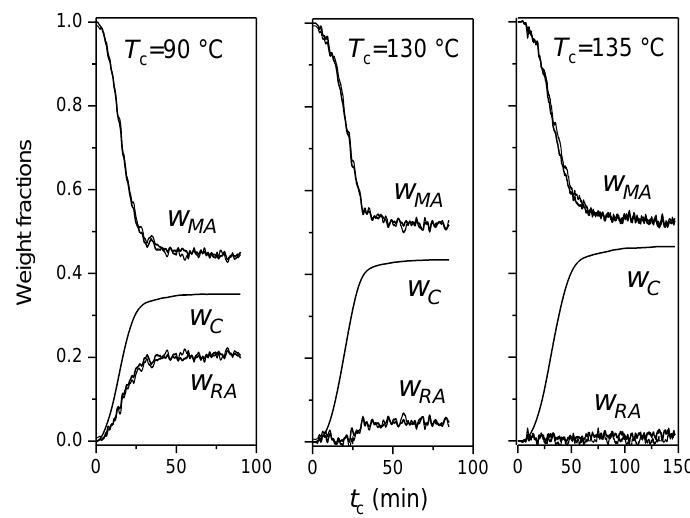
Figure 6. Time evolution of crystalline ( w C ), mobile amorphous ( w MA ) and rigid amorphous ( w RA ) weight fractions during quasi-isothermal crystallization from the melt of PLLA at T c = 90 °C, 130 °C, and 135 °C ( p = 60 s: thick line, p = 120 s: thin line, A T = 0.4 K). Estimated errors: ±0.02 for w C and w MA , ±0.04 for w RA . (Reprinted (adapted) with permission from [34]. Copyright (2011) Elsevier).